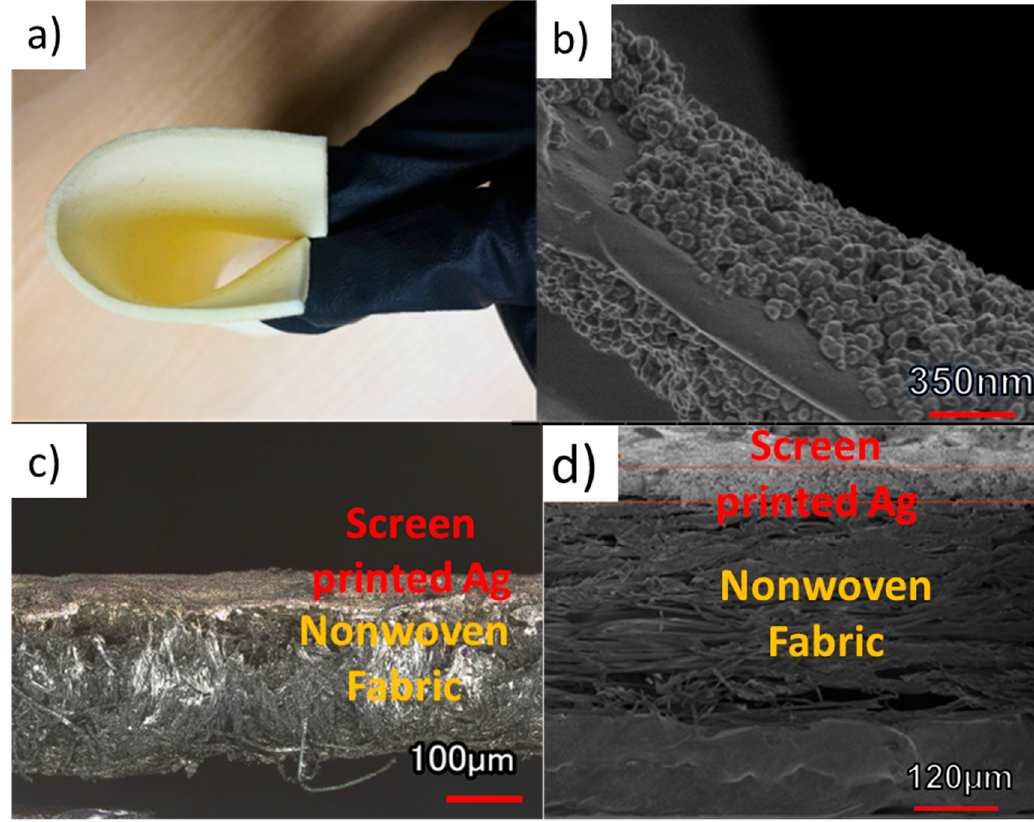
Figure 4. ( a ) Flexibility of the knit fabric assembly with BT dielectric ink and ( b ) an SEM image of the BT with acrylate and urethane UV-curable dielectric ink coated on a single fiber within the fabric after UV curing for 5 min (10,000×, 350 nm of scale bar). ( c ) Cross-sectional microscope image of Ag screen-printed patch section of the antenna (20×, 100 μ m of scale bar). ( d ) Cross-sectional SEM image of Ag screen-printed patch section of the antenna (150×, 120 μ m of scale bar).